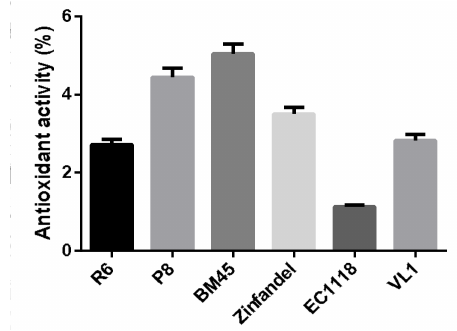
Figure 1. Antioxidant activity of the experimental wines measured as absorbance produced by the reduction of DPPH.